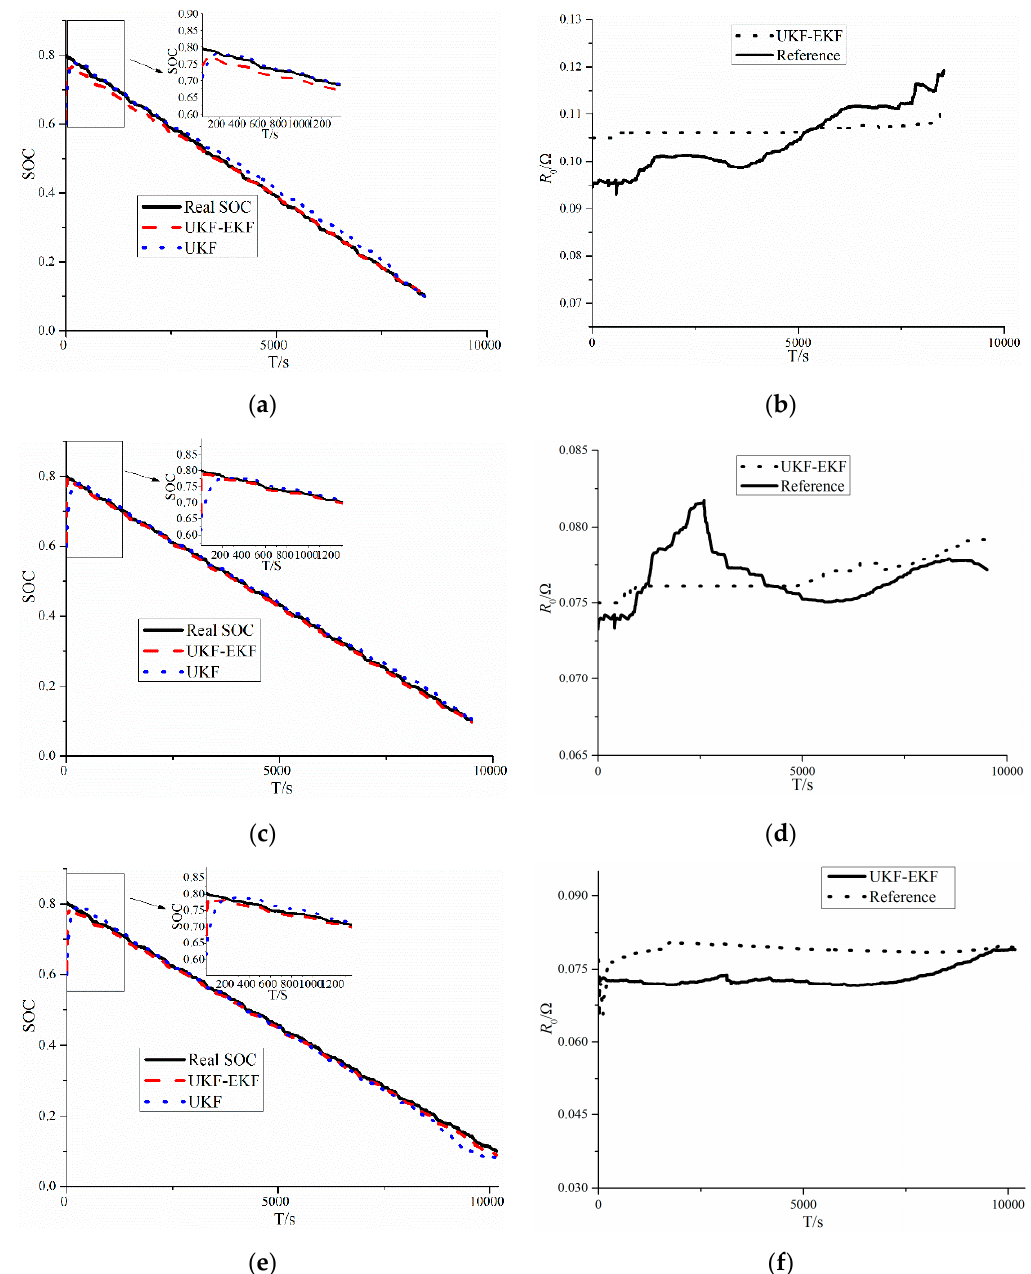
Figure 8. Results of estimation of the SOC and R 0 in BJDST: ( a ) SOC comparison between the UKF–EKF and UKF at 0 °C; ( b ) R 0 identification of the UKF–EKF at 0 °C; ( c ) SOC comparison between the UKF–EKF and UKF at 25 °C; ( d ) R 0 identification of the UKF–EKF at 25 °C; ( e ) SOC comparison between the UKF–EKF and UKF at 45 °C; ( f ) R 0 identification of the UKF–EKF at 45 °C.